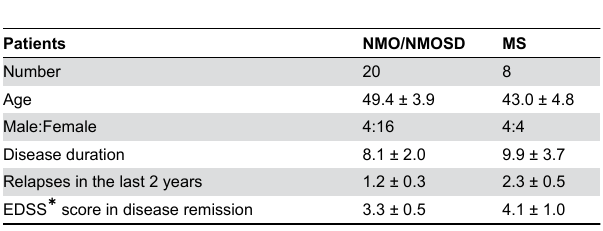
Table 1. The clinical profiles of patients with neuromyelitis optica (NMO)/NMO NMO spectrum disorder (NMOSD) and multiple sclerosis